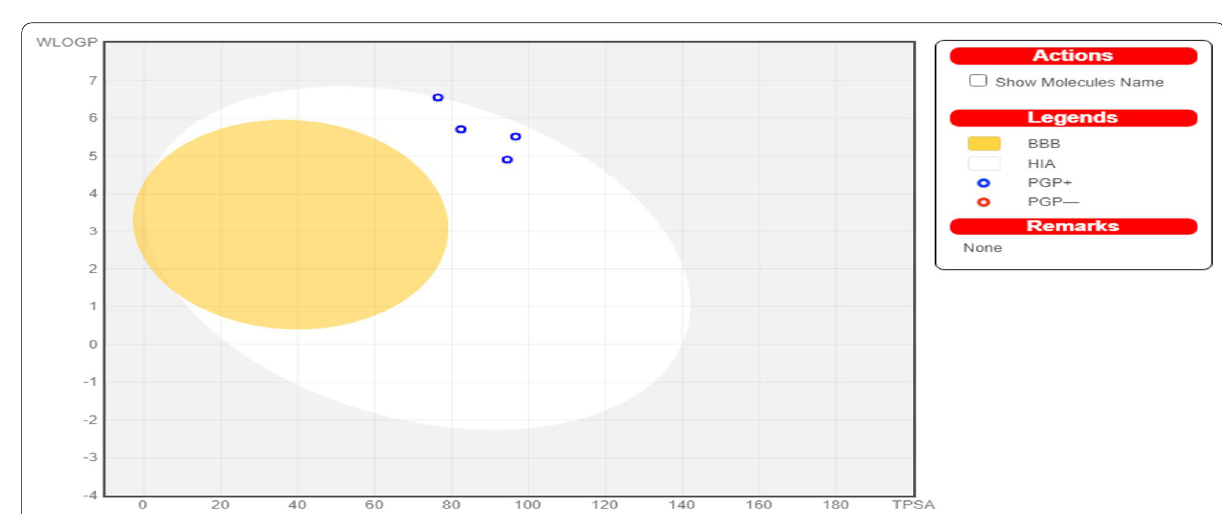
Fig. 8 Boiled egg plot of designed compounds 6, 8, 11 and